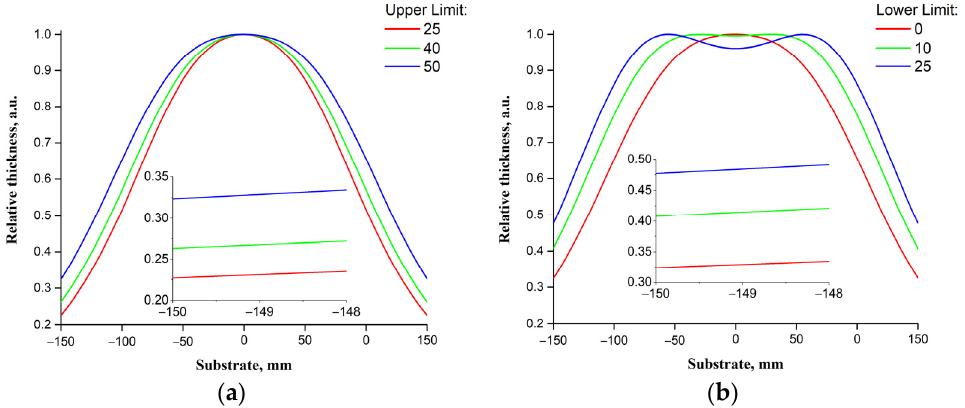
Materials 2021 , 14 , x FOR PEER REVIEW Figure 6. Dependencies of the relative thickness of the LiNbO 3 film on the Upper Limit ( a ) and Lower Limit ( b ) parameters.